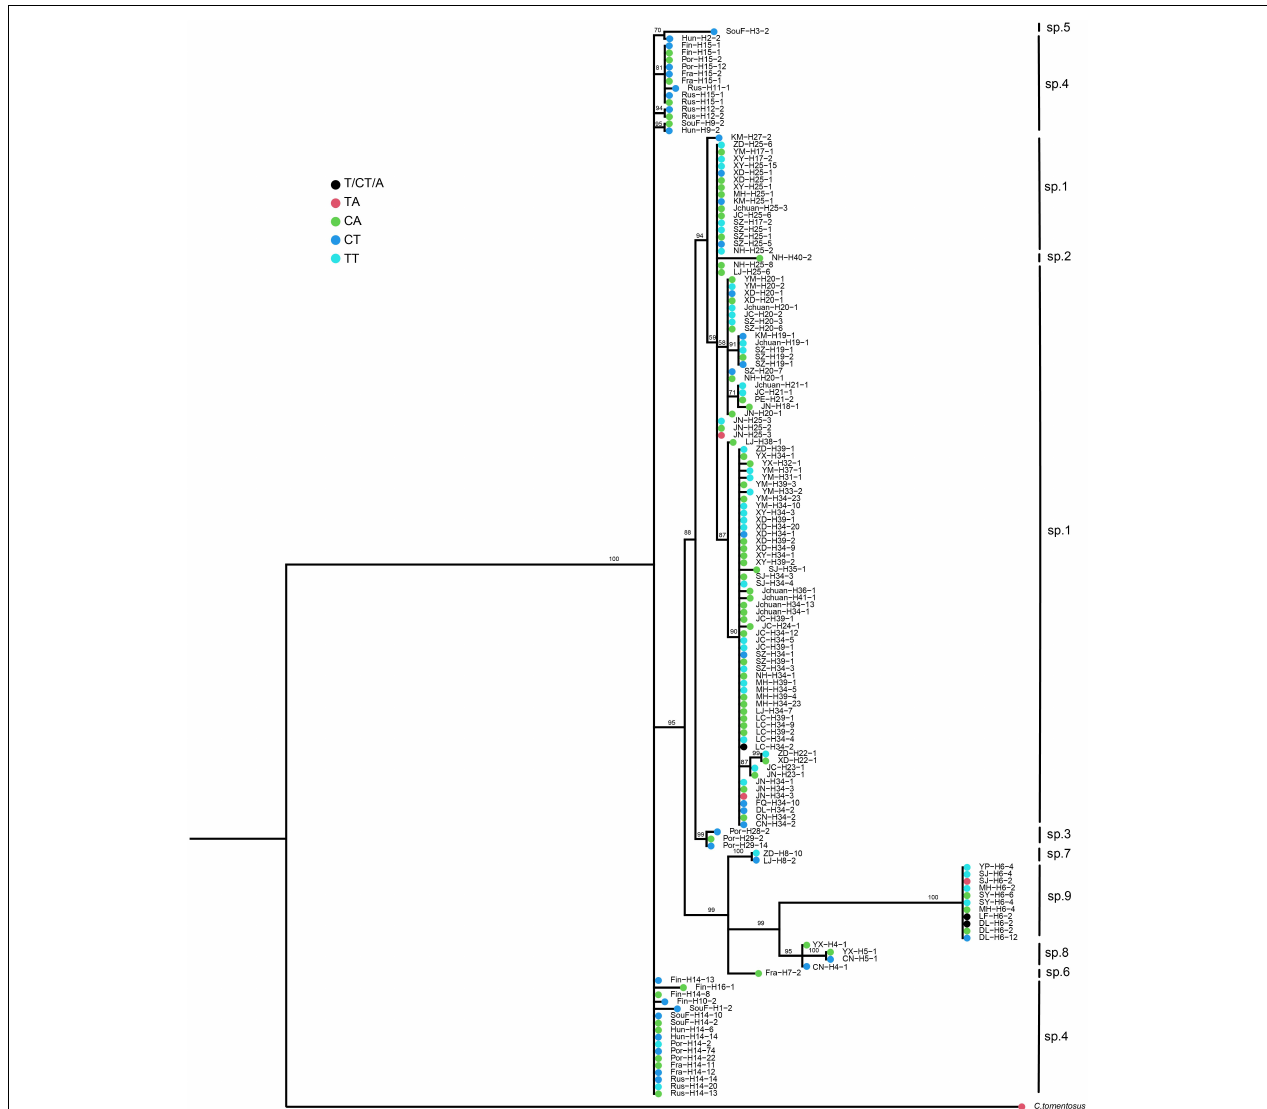
FIGURE 3 | Bayesian tef-1 haplotype cladogram showing the broad distributions of atp6 genotypes at two polymorphic nucleotide sites. Termina branch colors represent the different atp6 genotypes at the two polymorphic sites; For each tef-1 haplotype in our samples, the name or abbreviation (full name can be found in Supplementary Table 2 ) represents the county/community from where the sample was obtained, the number after “H” represent the haplotype assignment; the last number represents the total number of samples belonging to the specific haplotype from each geographic location and for each unique atp6 genotype. Only representative sequences of unique haplotypes from each geographic location and unique atp6 genotypes are